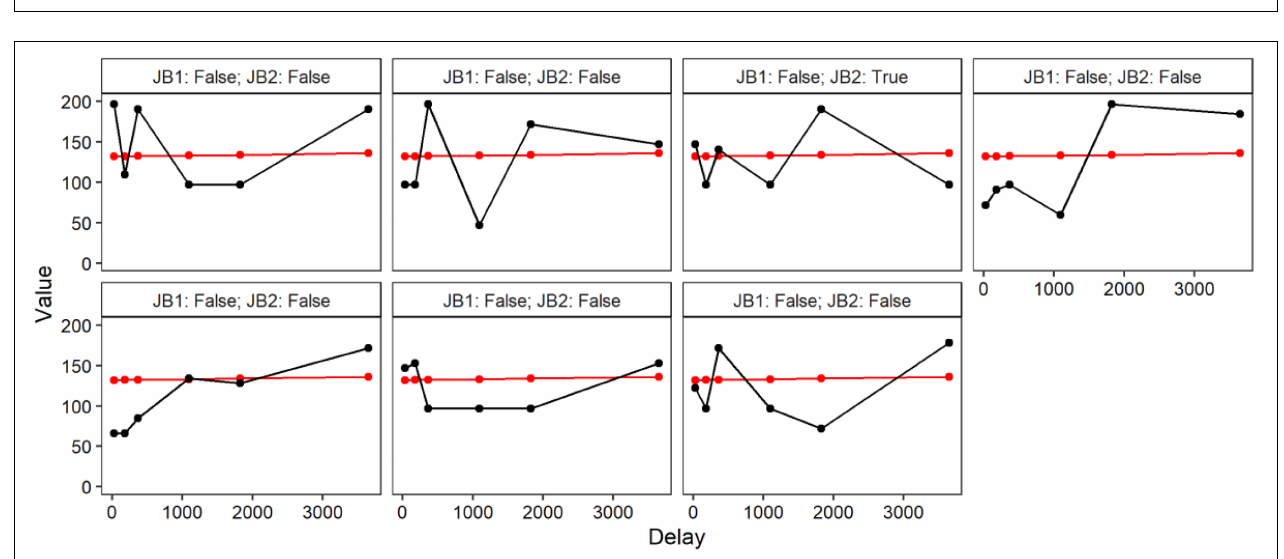
FIGURE 1 | Latent class analysis and systematic criteria of low magnitude task ($200).